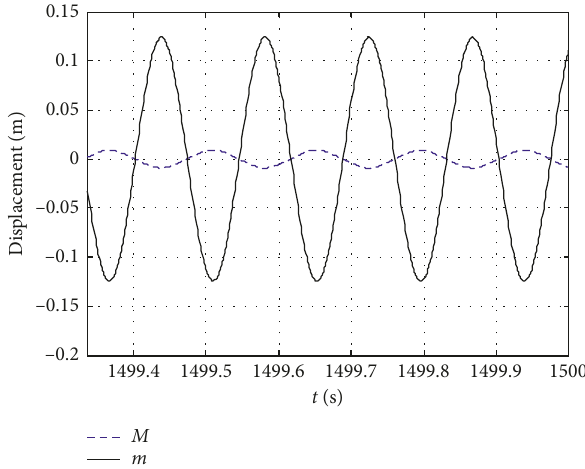
Figure 10: Displacement time history curves of shell and oscillator in period 1.